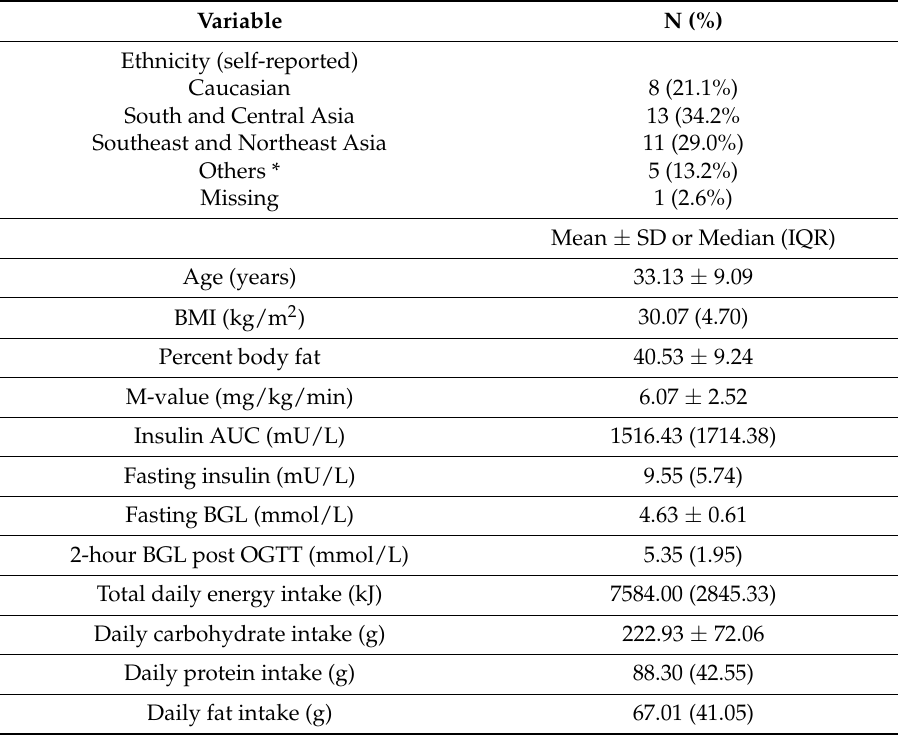
Table 1. The participants’